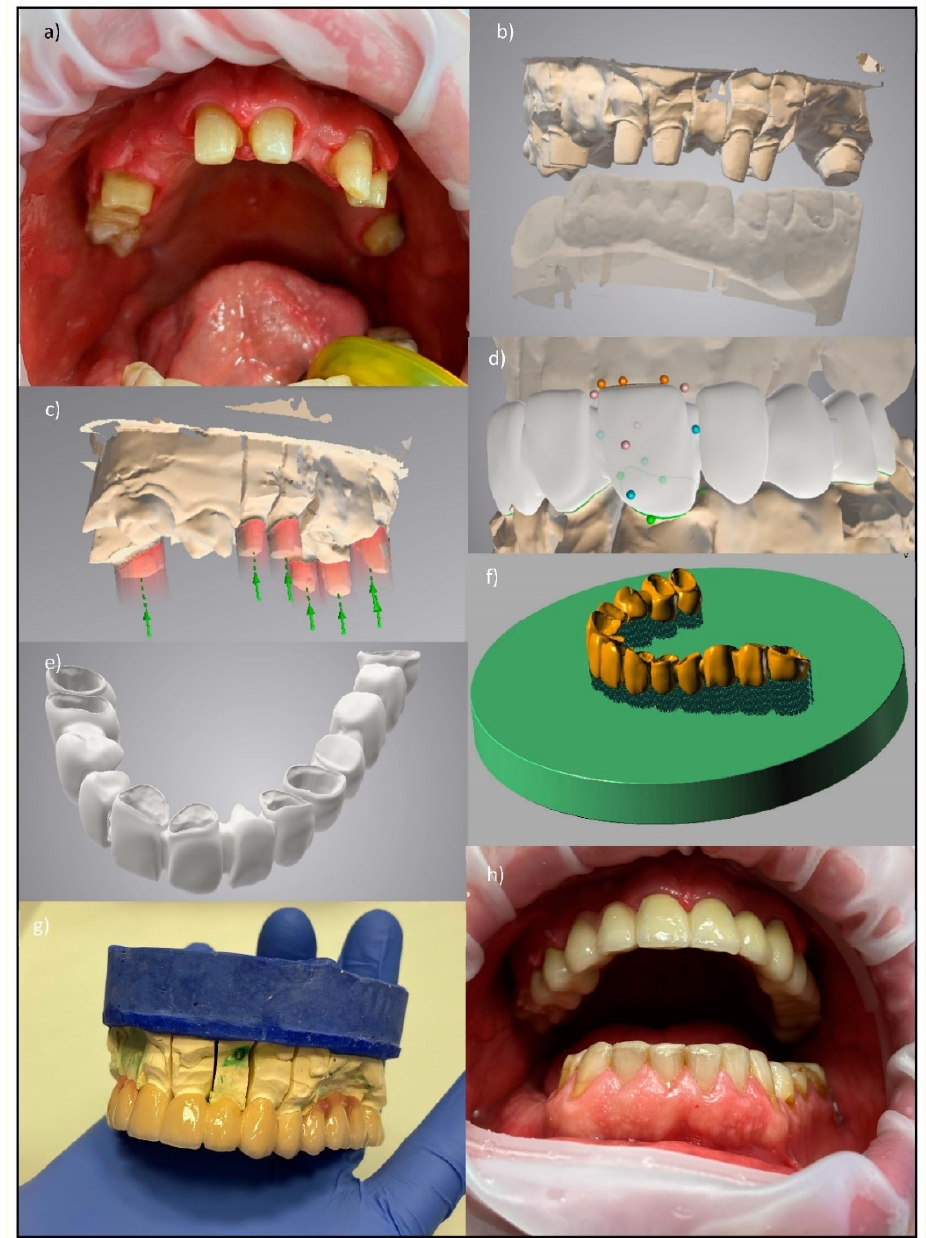
Figure 15. Description of the procedure for the production of dental bridges using the technology of selective laser sintering (SLS) from metal powders; a detailed description of the meaning of ( a – h ) images in the text. ( a ) preparing teeth for treatment; ( b ) virtual tooth model together with post models; ( c ) considering pillars; ( d ) prosthetic reconstruction project; ( e ) finished model; ( f ) designed supports; ( g ) tooth forming; ( h ) final result.